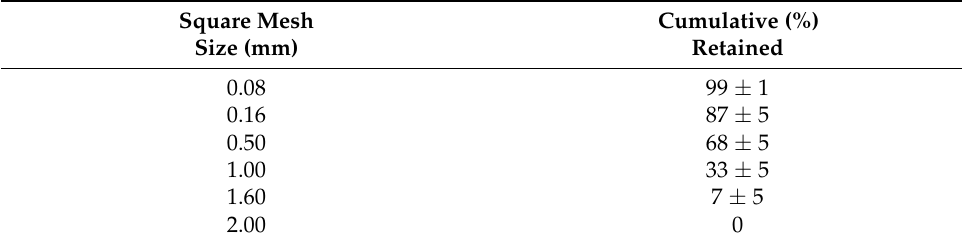
Table 2. Particle size distribution of the standard sand